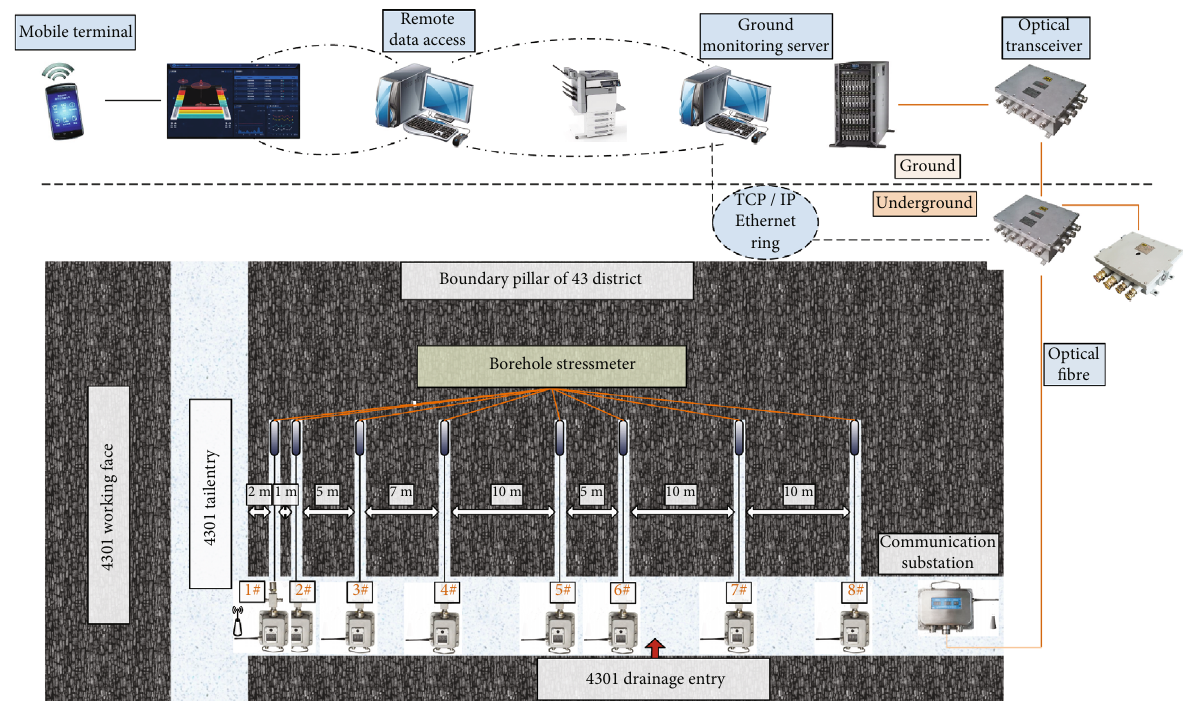
Figure 5: Layout plan of borehole stress meter.